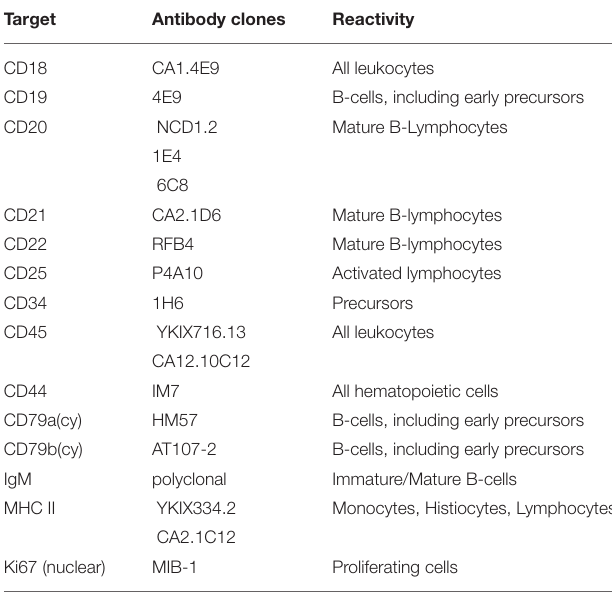
TABLE 1 | Possible correlation between updated Kiel classification and WHO classification for B-Cell Lymphomas according to (3). Updated Kiel classification